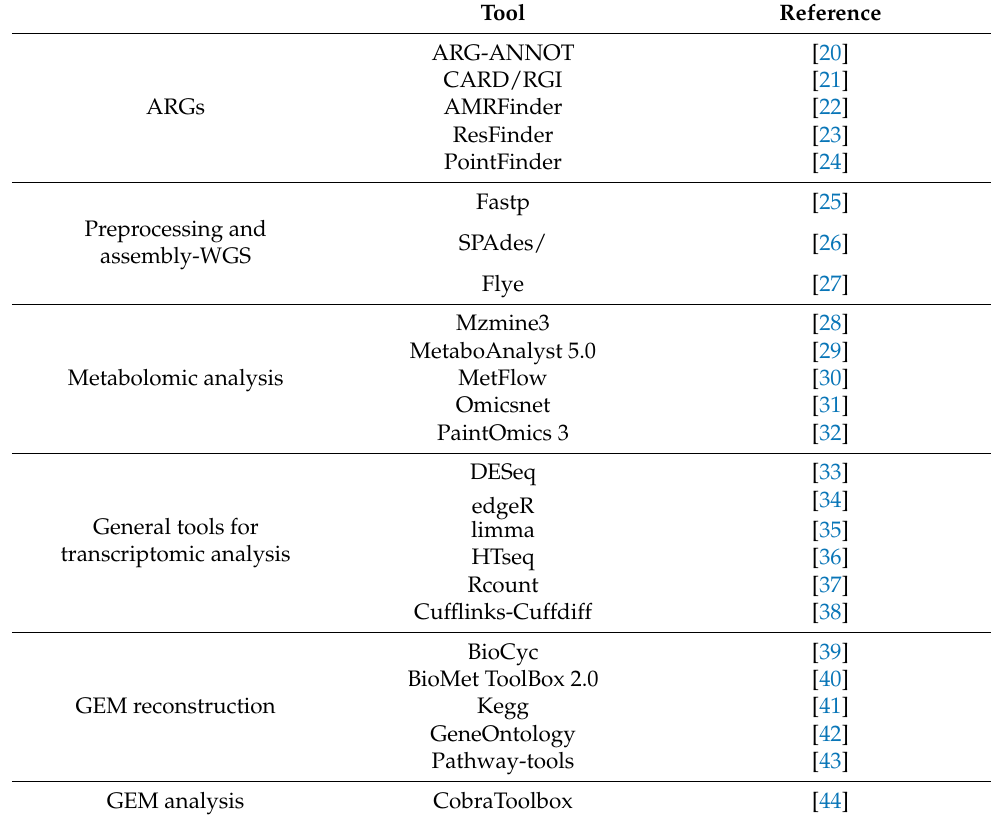
Table 1. Bioinformatics